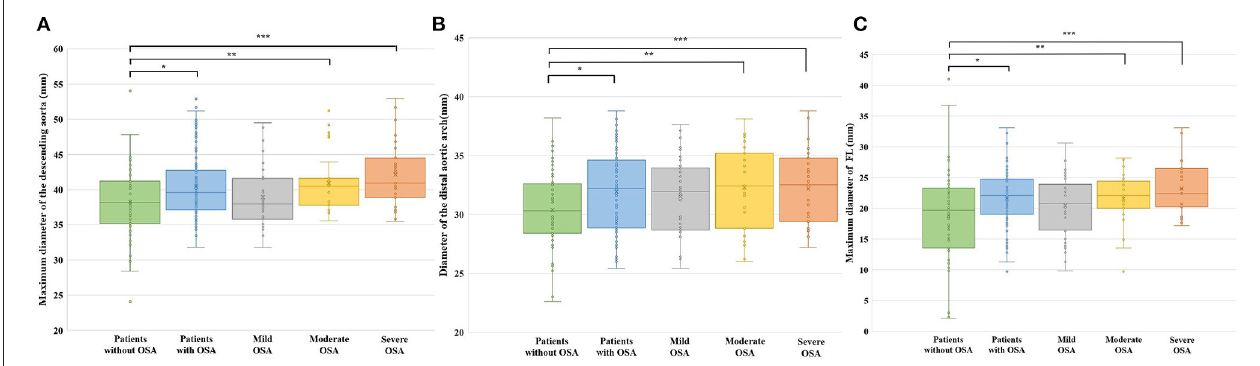
FIGURE 3 | Other imaging differences in different OSA severities. (A) Maximum diameter of the descending aorta for different OSA severities. * p = 0.029; ** p = 0.037; *** p = 0.001. (B) Diameter of the distal aortic arch for different OSA severity levels. * p = 0.008; ** p = 0.022; *** p = 0.026. (C) Maximum diameter of the FL for different OSA severity levels. * p = 0.018; ** p = 0.038; *** p =